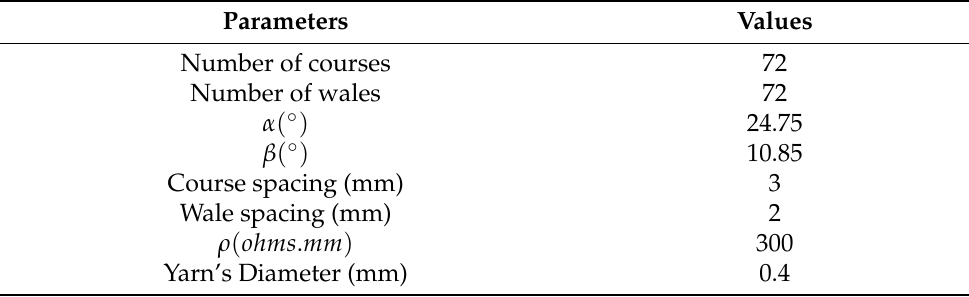
Figure 6. Unit circuit diagram of samples with miss stitches. ( a ) 6.25% miss stitches; ( b ) 8.33% miss stitches; ( c ) 16.67% miss stitches ( d ) 25% miss stitches. Table 2. Numerical Parameters for